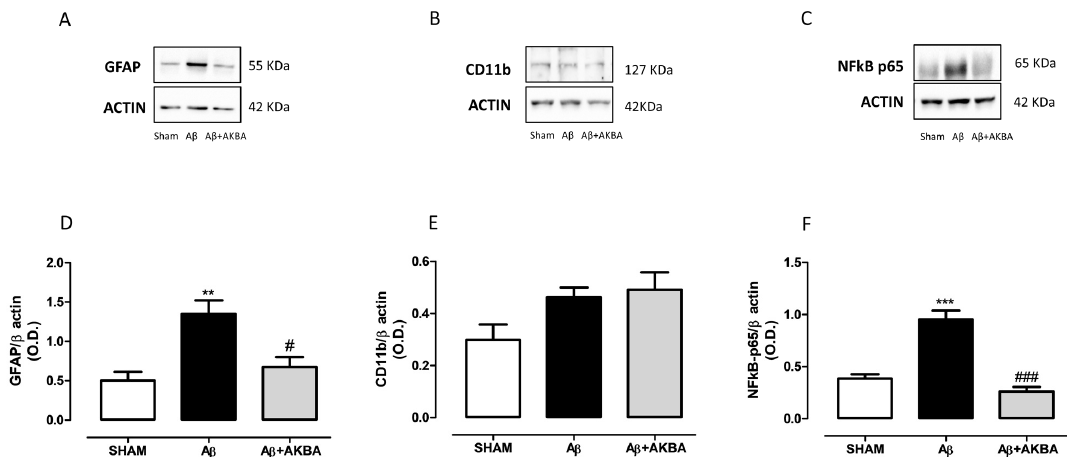
Figure 6. Effects of AKBA administration on cortical GFAP, CD11b and NFkB-p65 levels. Representative image of Western blotting of ( A ) GFAP, ( B ) CD11b and ( C ) NFkB-p65. ( D ) Quantification of the optical density of GFAP bands normalized to the actin protein value in the PFC of mice 7 days after icv injection of vehicle (SHAM, 5 µL, white bar), A β (A β , 4 µM, black bar), and A β +AKBA (A β , 4 µM + sublingual AKBA, 5 mg/kg, gray bar), (SHAM n = 5, A β n = 4, A β +AKBA n = 4). ( E ) Quantification of the optical density of CD11b bands normalized to the actin protein value in the PFC of mice 7 days after icv injection of vehicle (SHAM, 5 µL, white bar), A β (A β , 4 µM, black bar), and A β +AKBA (A β , 4 µM + sublingual AKBA, 5 mg/kg, gray bar), (SHAM n = 4, A β n = 4, A β +AKBA n = 4). Quantification of the optical density of NFkB-p65 bands normalized to the actin protein value in the PFC of mice 7 days after icv injection of vehicle (SHAM, 5 µL, white bar), A β (A β , 4 µM, black bar), and A β +AKBA (A β , 4 µM + sublingual AKBA, 5 mg/kg, gray bar), ( F ) SHAM n = 4, A β n = 4, A β +AKBA n = 4). One-way ANOVA followed by Tukey’s multiple comparison test, ** p < 0.01, *** p < 0.001 A β versus SHAM; # p < 0.05, ### p < 0.001 A β +AKBA versus A β .